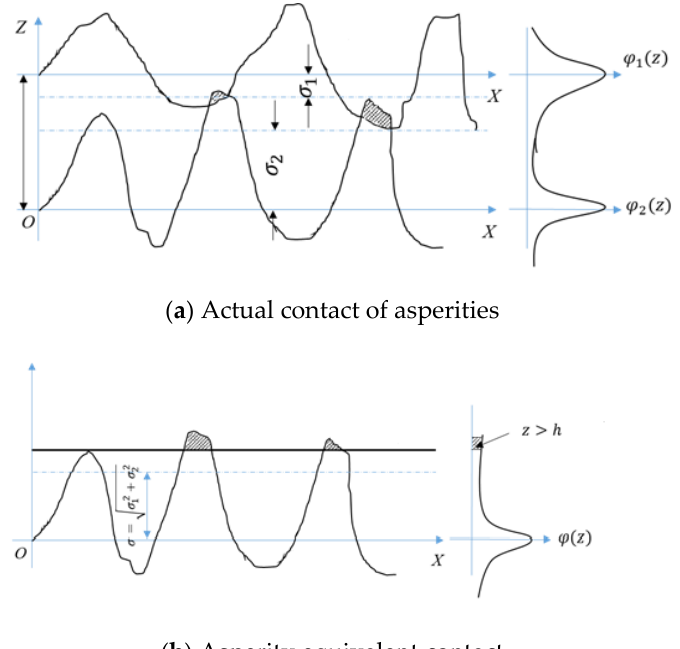
Figure 4. Actual contact between friction plate and mating steel plate.